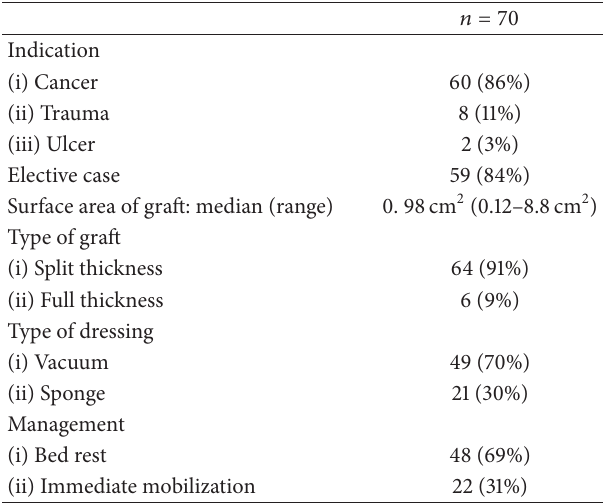
Table 2: Operative details of lower limb skin grafts, data presented as ( 𝑛 , %) unless otherwise